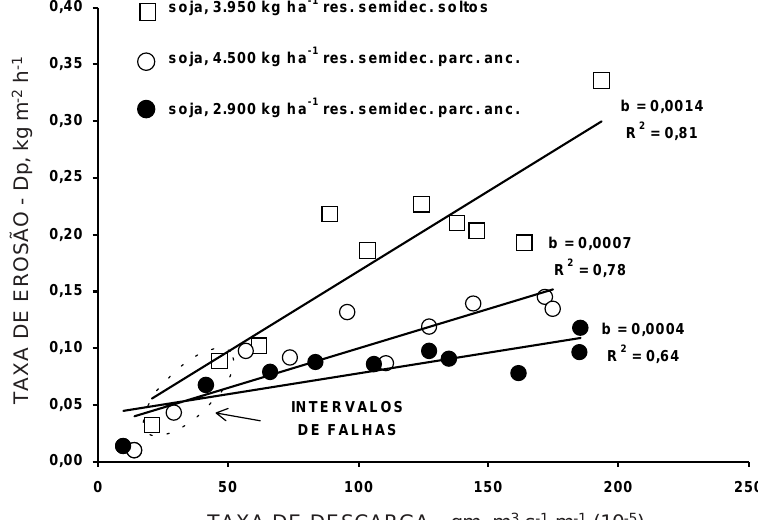
Figura 4. Relação da taxa média de erosão, Dp, com a taxa de descarga no ponto médio da parcela, qm, nos tratamentos com 4.500 e 2.900 kg ha -1 de resíduos de soja, ambos semidecompostos e parcialmente ancorados, e 3.950 kg ha -1 de resíduos semidecompostos de soja soltos, no sistema de semeadura direta (Experimento